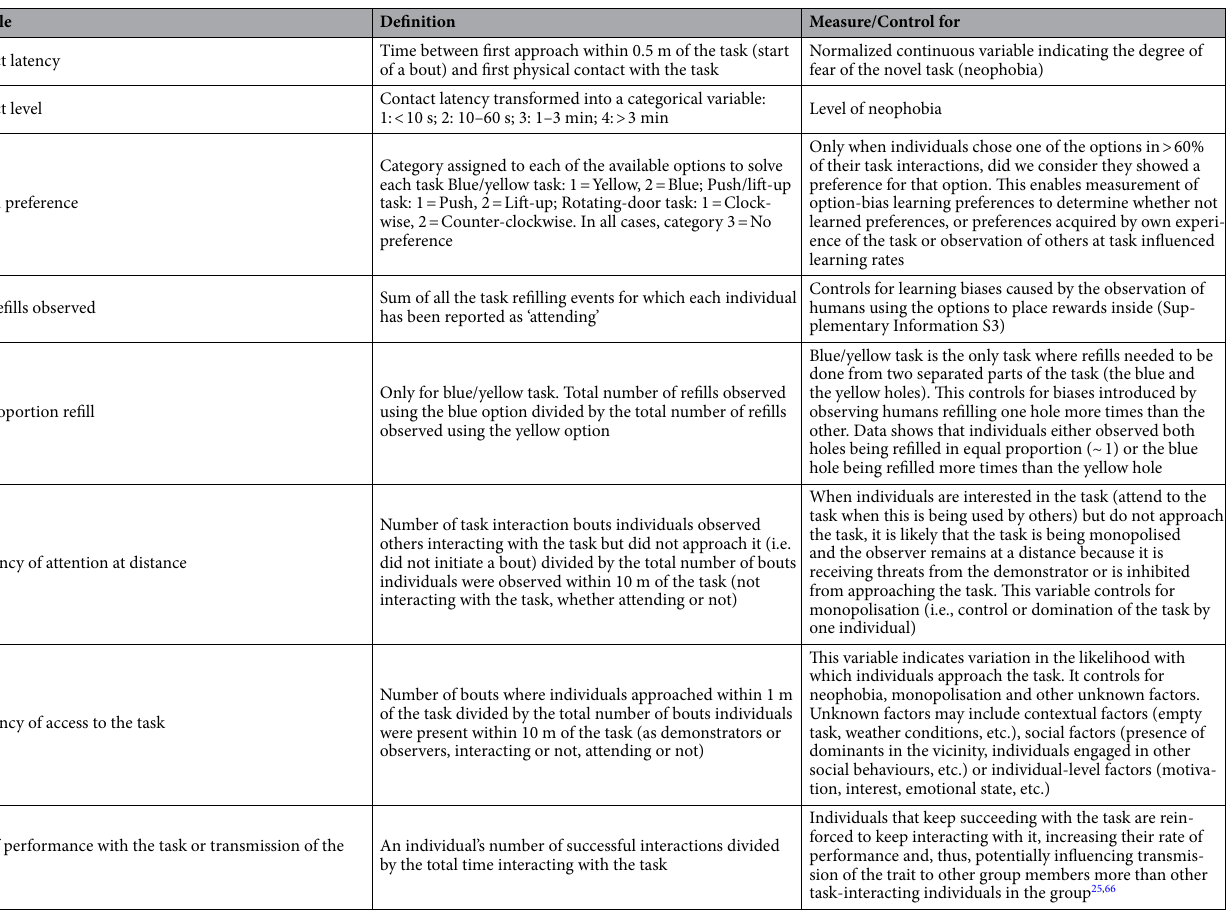
Table 2. Task-related interactions used to control for individual-level confounding factors in the network- based diffusion analysis (NBDA) performed in a group of Barbary macaques at Trentham Monkey Forest (UK). 1 This variable is entered in NBDA as part of the function to calculate non-constant rates of social